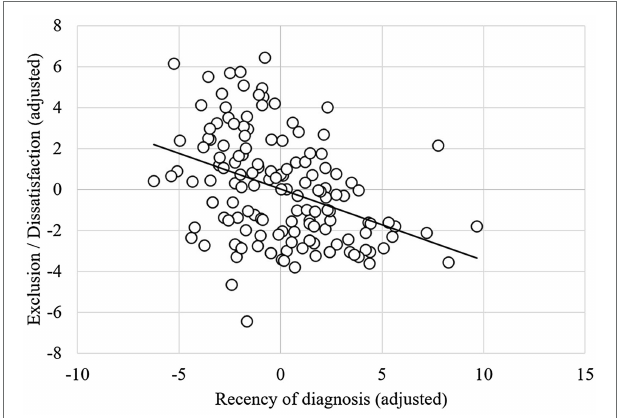
FIGURE 1 | Partial regression plot showing the relationship between recency of diagnosis and exclusion/dissatisfaction (controlling for other variables in the